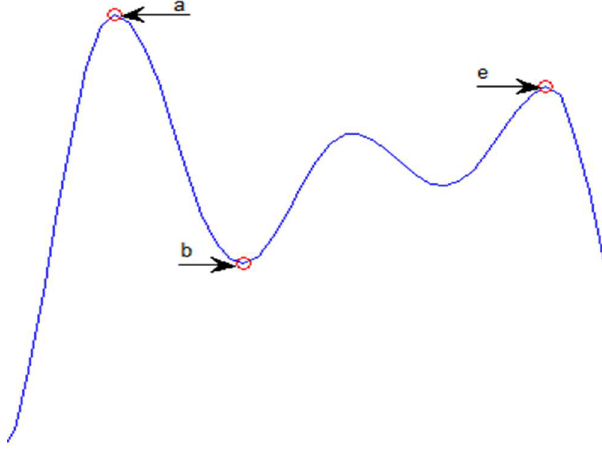
Figure 4. Parameters of the APG signals are: the "a" wave is the early systolic positive wave or the first positive peak of APG, the "b" wave is the early systolic negative wave or the first negative peak of APG, and the "e" wave characterizes a dicrotic notch.